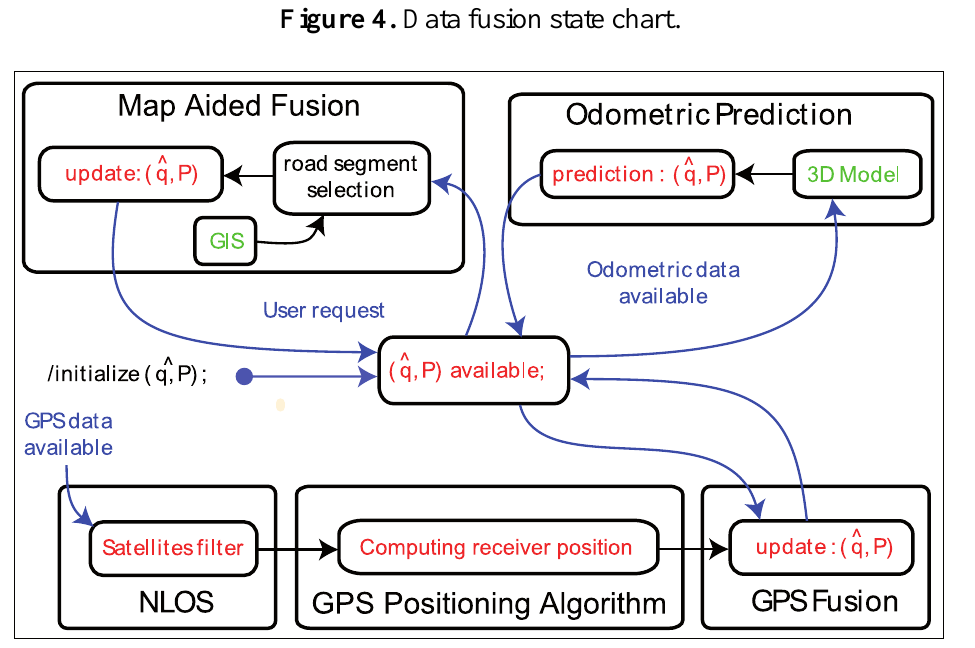
Figure 4. Data fusion state